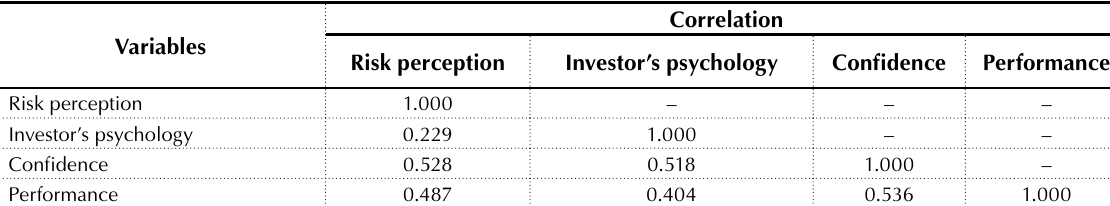
Table 9. The result of test validity